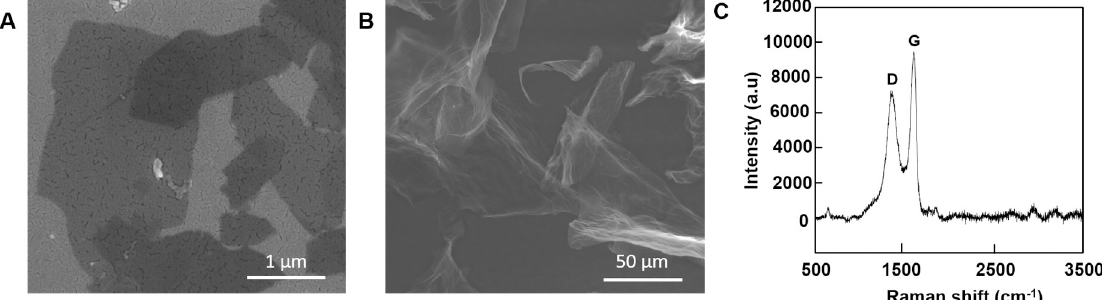
Fig 1. Characterization of graphene. (A, B) Scanning electron microscope images of graphene; (C) Raman spectra of graphene.